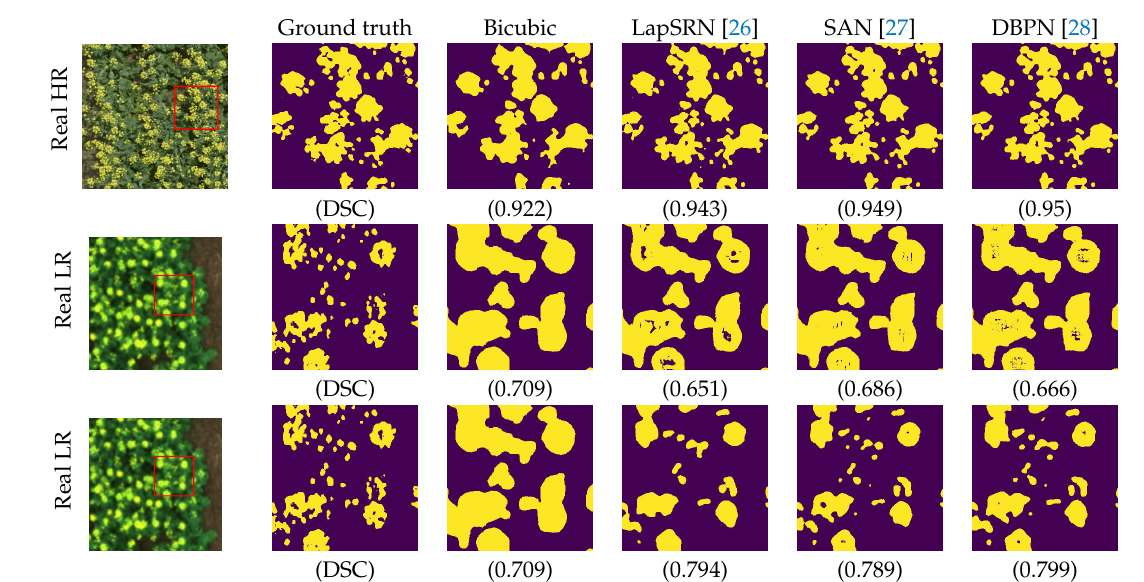
Figure 7. Example test images for vegetation segmentation for the synthetic-synthetic (top row), synthetic-real (middle row), and real-real (bottom row) experiments on the canola dataset during the flowering stage to segment flowers. Yellow pixels indicate flower segmentation (foreground) and DSC values are listed below each image.